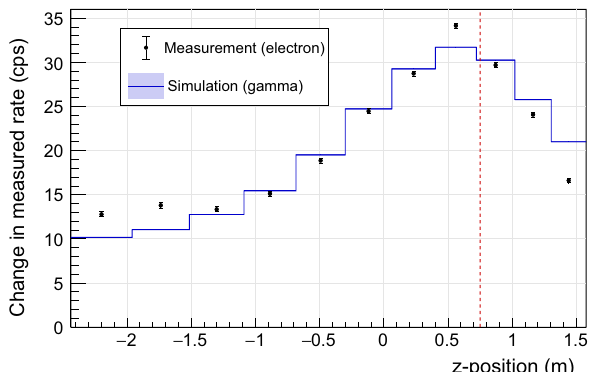
Fig. 7 The excess FPD rate measured with the Asym. M magnetic field setting with the 60 Co source, as a function of the axial position z . Each bin corresponds to a detector pixel ring which images a specific axial region of the MS surface. Also shown is the simulated gamma flux induced by the source at the inner surface of the MS, which has been scaled to match the total measured rate. The error bars for the measurement and simulation data are statistical only; each of the bin errors for the simulation data is less than 0.4 % of the bin content, and so the error bars are too small to be seen for most bins. The systematic errorsforthesimulationdataarisingfromtheactivityofthe 60 Cosource are correlated bin-to-bin and are therefore not shown. The location of the 60 Co source in the simulation geometry is marked by the dashed